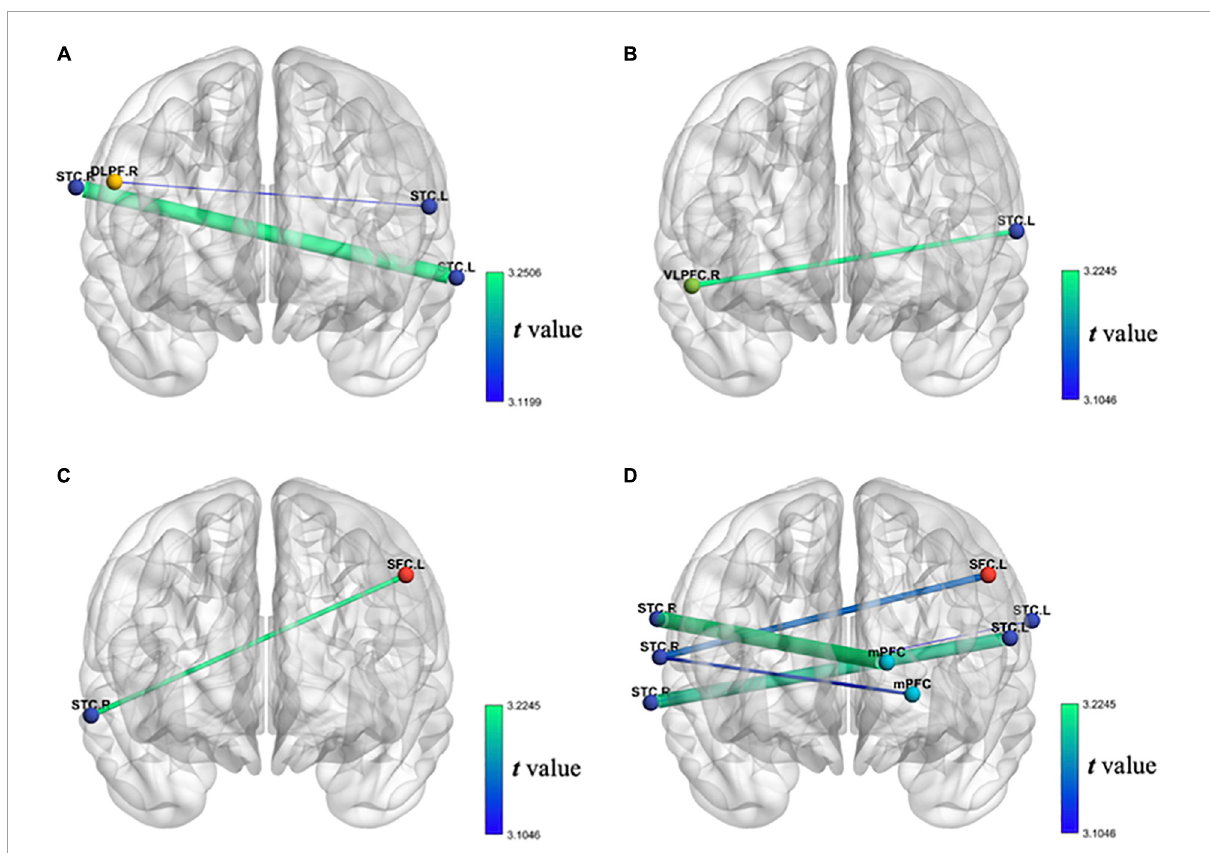
FIGURE7 (A) Decrease of FC of oxy-Hb during VFT in patients with stroke compared with the healthy individual group; (B) the decrease of FC of oxy-Hb during VFT of the first test compared with the second test in patients with stroke; (C) the increase of FC of oxy-Hb during VFT of the first test compared with the third test in patients with stroke; (D) the increase of FC of oxy-Hb during VFT of the second test compared with the third test in patients with